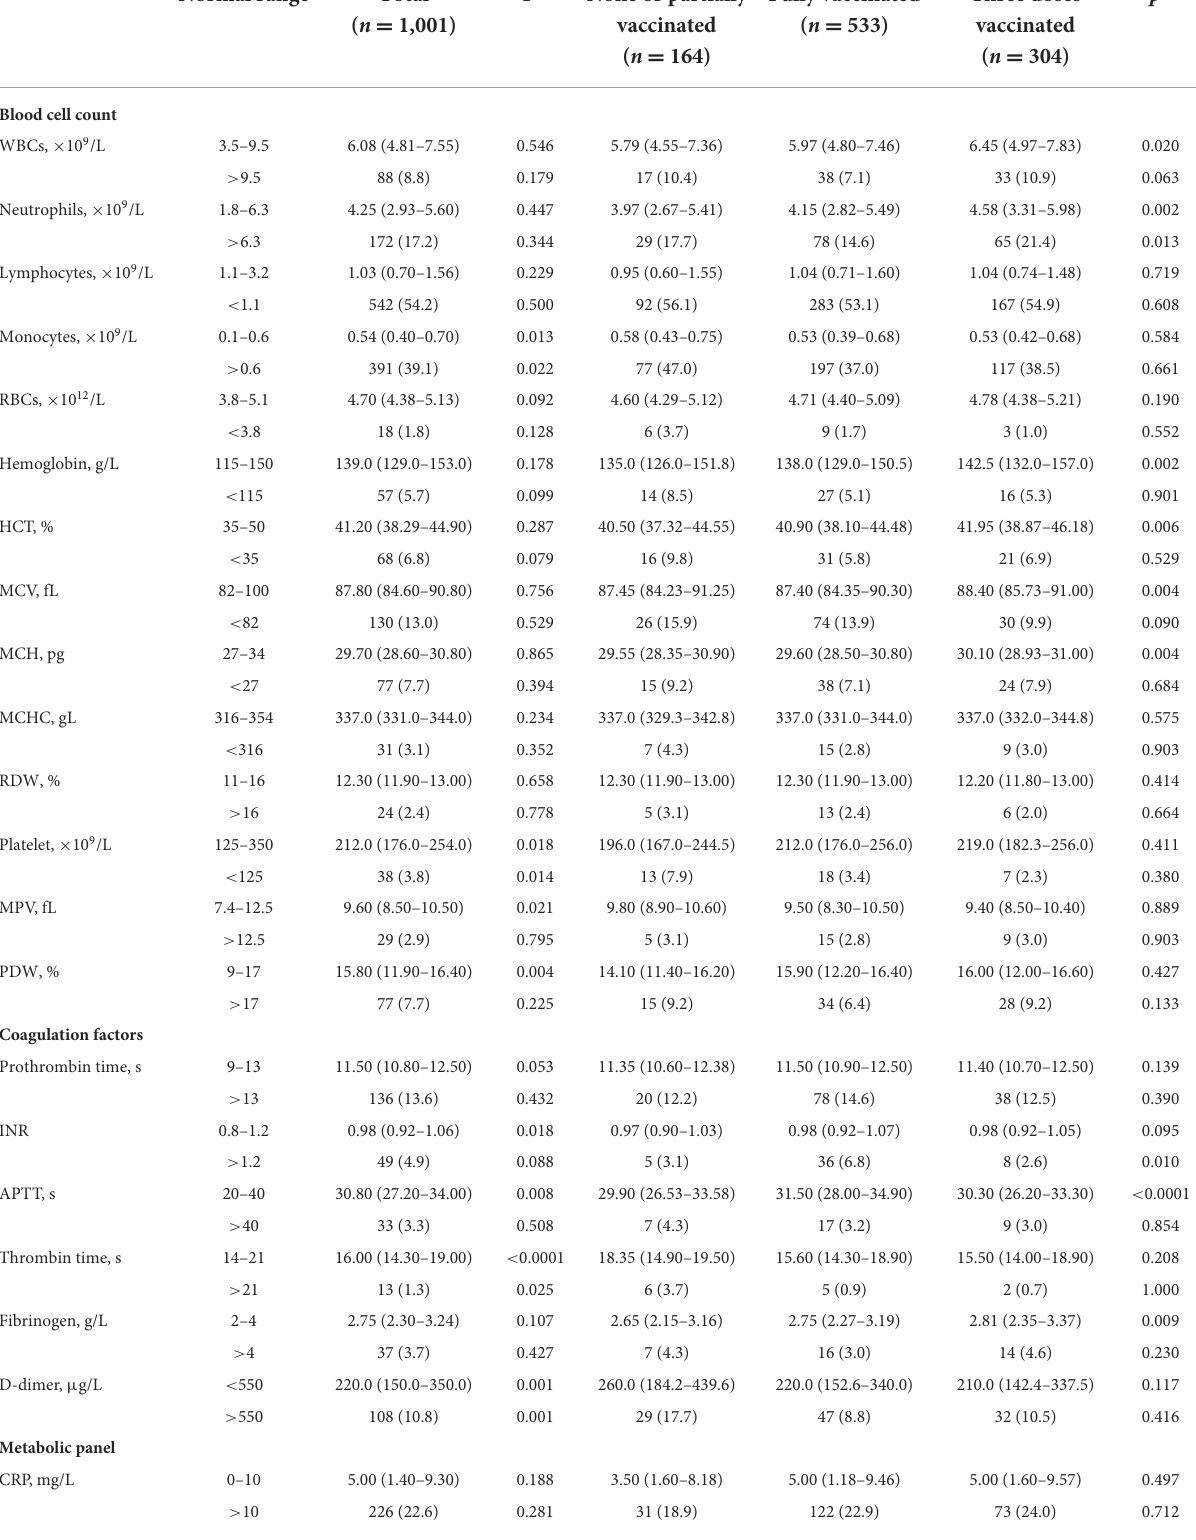
TABLE 2 Baseline characteristics of COVID-19 patients infected by the omicron variant in their hematological profiles. Normal